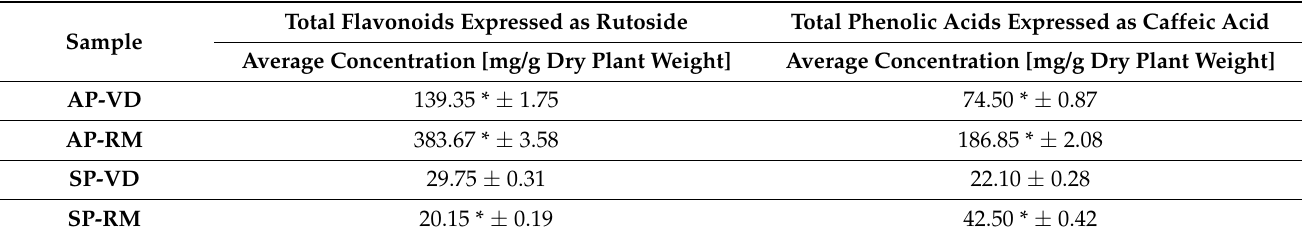
Table 2. Quantity of total flavonoids and total phenolic acids in aerial (AP) and subterranean parts (SP) of T. farfara hydro-ethanolic extracts.